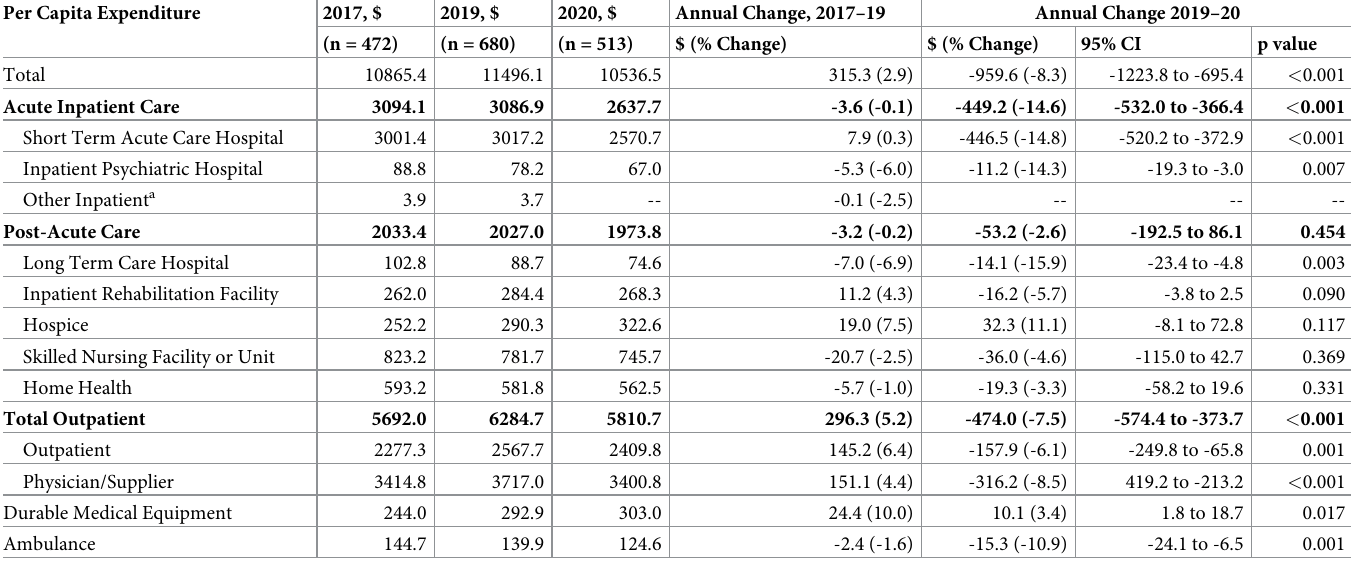
Table 1. Changes in per capita expenditures by service line,